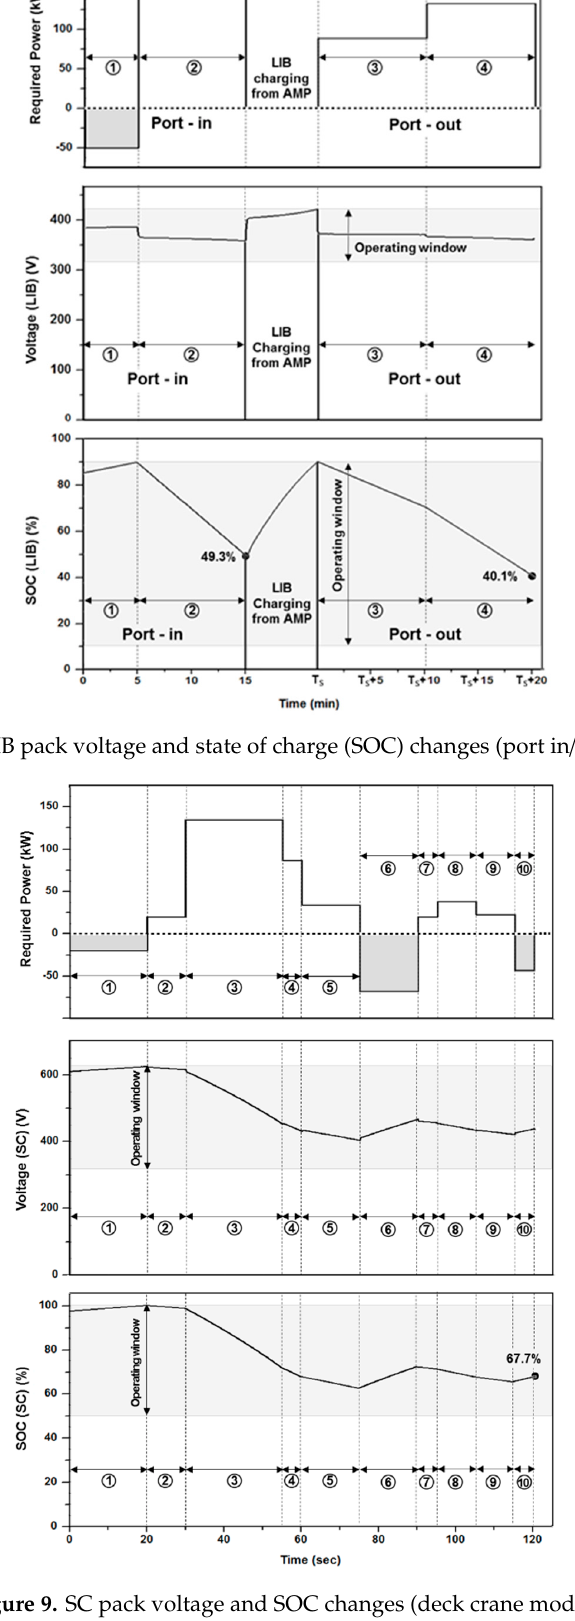
Figure 9. SC pack voltage and SOC changes (deck crane